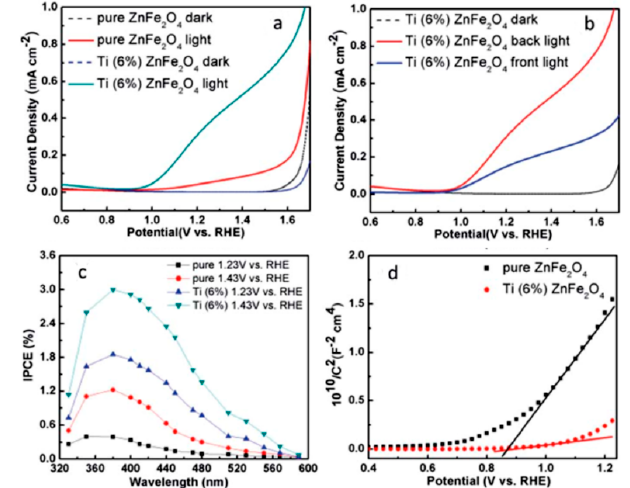
Figure 10. The photocurrents of ( a ) ZnFe 2 O 4 photoanodes and Ti-doped ZnFe 2 O 4 photoanodes in 1 M NaOH aqueous solution under AM 1.5 G illumination (100 mW·cm − 2 ); ( c ) IPCE spectrum of Ti-doped ZnFe 2 O 4 and pure ZnFe 2 O 4 in range from 330 to 589 nm at different applied potential; ( d ) Mott–Schottky plots of pure Ti-doped ZnFe 2 O 4 and ZnFe 2 O 4 photoanodes in 1 M NaOH, the AC amplitude is 5 mV and the frequency is 1000 Hz. Reprinted with permission from ref. [34]. Copyright 2018. American Chemical Society.